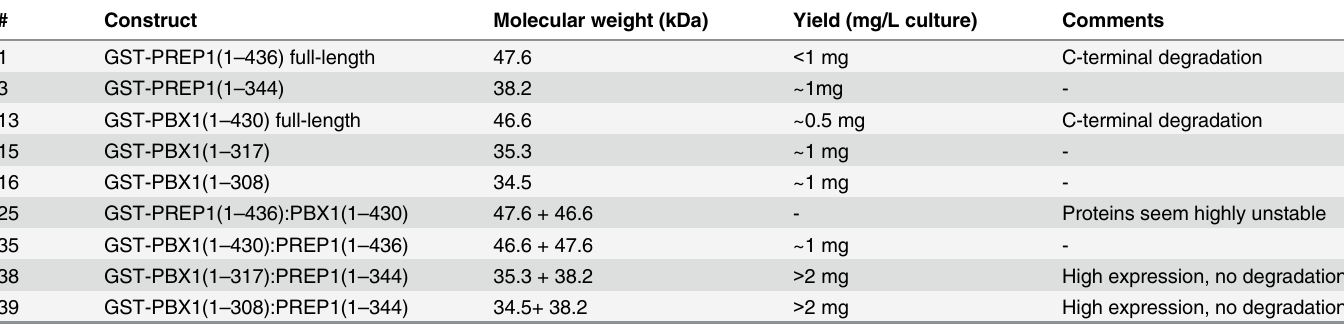
Table 1. Overview of PREP1 and PBX1